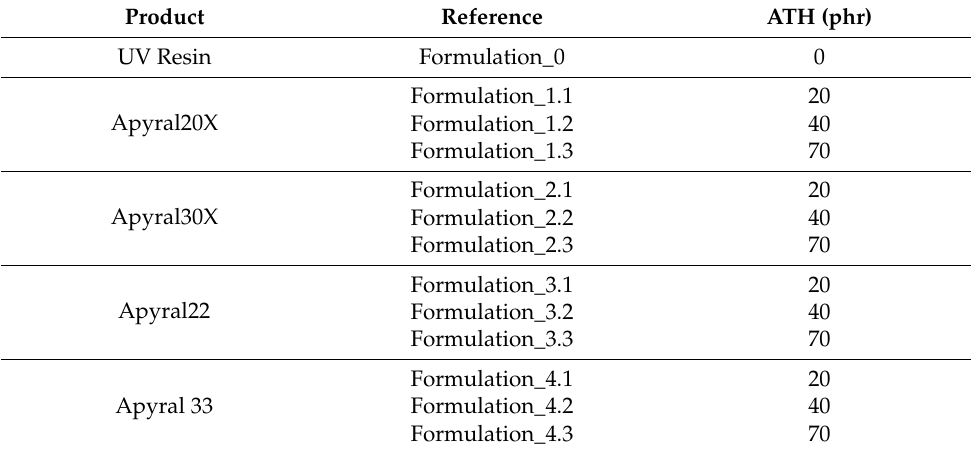
Table 2. Resin/filler blends prepared